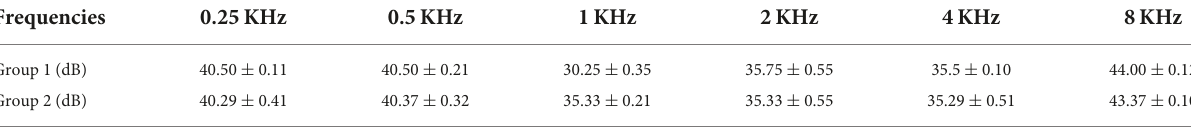
TABLE 5 The average preoperative differences in A-B gap of patients with type II labyrinthine fistulas in groups 1 and 2. Frequencies